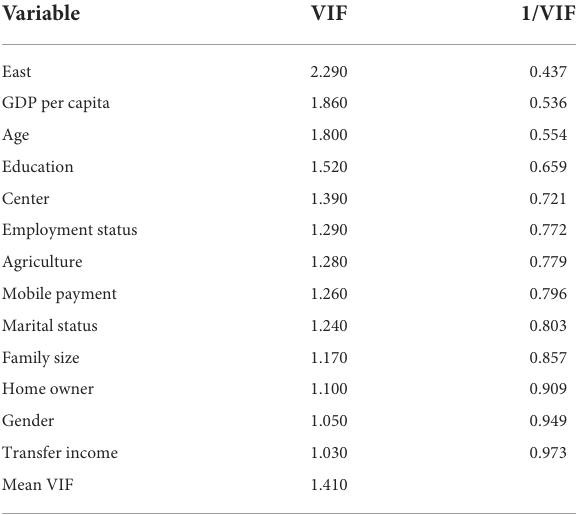
TABLE 2 Results of the multicollinearity